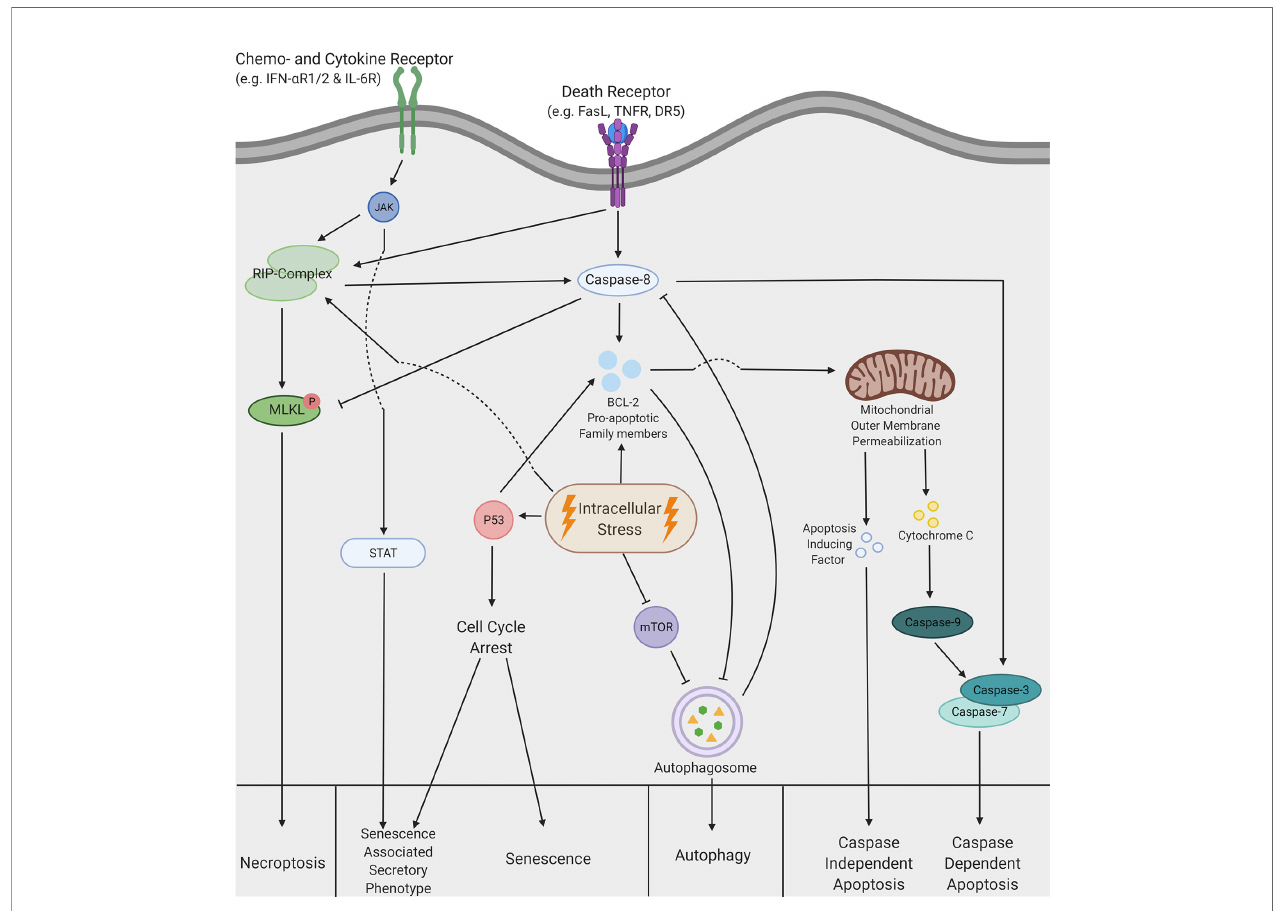
FIGURE 1 | A schematic overview of the complex pathways regulating cell death. Necroptosis can be triggered by both extrinsic and intrinsic stimuli. The extrinsic pathway can be activated by chemokine, cytokine and death receptors, which leads to the activation of receptor interacting protein (RIP)-kinases. Similar activation is also achieved via intracellular stress. Subsequently, activation of the RIP-complex leads to phosphorylation of mixed lineage kinase domain like pseudokinases (MLKL), which is inhibited by caspase-8 under normal circumstances. MLKL phosphorylation induces a translocation to the cell membrane, which leads to permeabilization of the cell and consequently necroptotic cells death. Senescence is predominantly induced via a cell cycle arrest initiated by p53, but this process can also lead to the senescence associated secretory phenotype (SASP). Moreover, SASP can be induced via extrinsic stimuli that activate the Janus kinase- signal transducer and activator of transcription (JAK-STAT) pathway. Intracellular stress can inhibit the mammalian target of rapamycin (mTOR) pathway, which allows formation of the autophagosome. This formation can be inhibited by pro-apoptotic members of the BCL-2 family but is also able to inhibit caspase cleavage and thereby displays the crosstalk between autophagy and apoptosis. Eventually, after formation of the autophagosome, autophagic cell death is induced. Additionally, apoptosis can be induced by both intrinsic and extrinsic stimuli. Extrinsic stimuli allow cleavage of caspase-8, which can either induce cleavage of the caspase3/7 complex or activate members of the pro-apoptotic BCL-2 family. Activation of caspase3/7 results in caspase dependent apoptosis. However, the BCL-2 proteins can also be activated by intrinsic stimuli or intracellular stress and lead to the mitochondrial outer membrane permeabilization (MOMP), which in turn releases both cytochrome C and apoptosis inducing factors (AIF). Cytochrome C interacts with caspase-9 and subsequently induces caspase-dependent apoptosis via the activation of caspase 3/7. In contrast, AIF facilitates caspase-independent apoptosis by initiation of chromatin condensation and DNA fragmentation. This fi gure was created by authors using Biorender tools